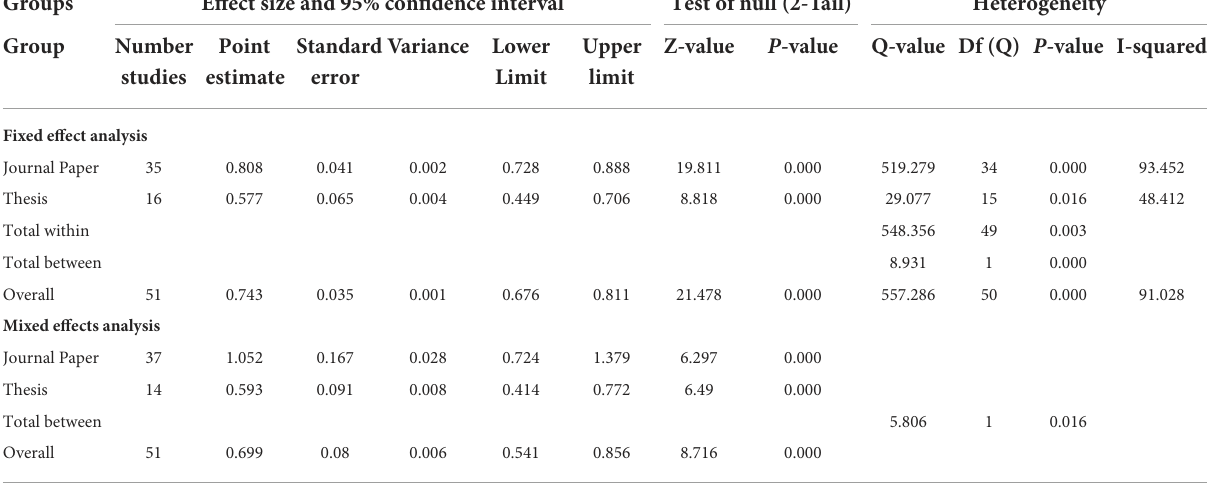
TABLE 8 Moderator analysis of literature source.